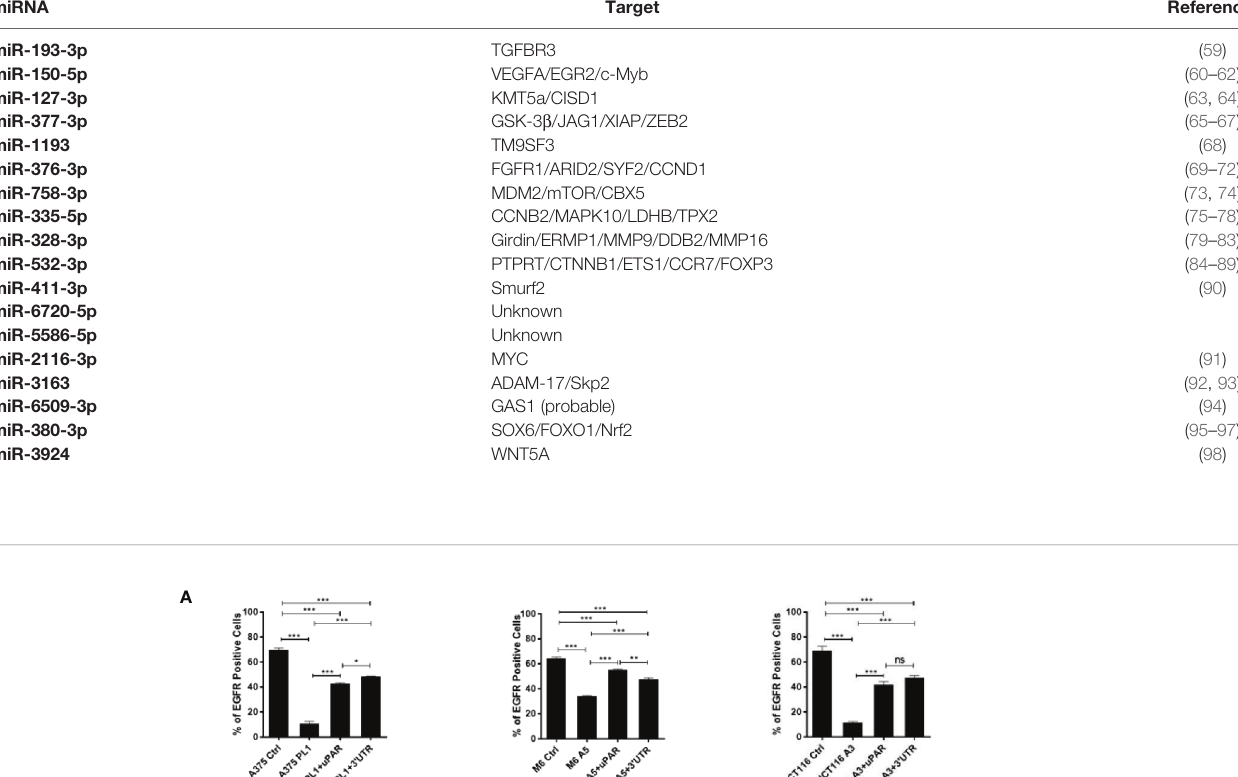
TABLE 2 | Analysis of predicted